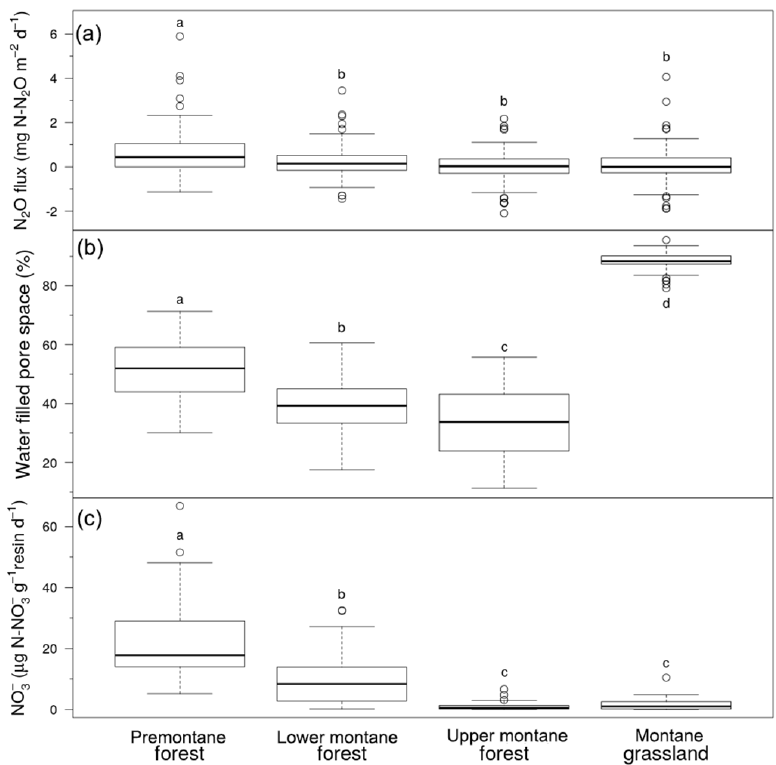
Figure 2. Plot-averaged (a) net N 2 O flux, (b) water-filled pore space, and (c) resin-extractable NO − the interquartile range, whiskers indicate the 90th and 10th percentiles. Lower case letters indicate statistically significant differences among means (Fisher’s LSD, P <